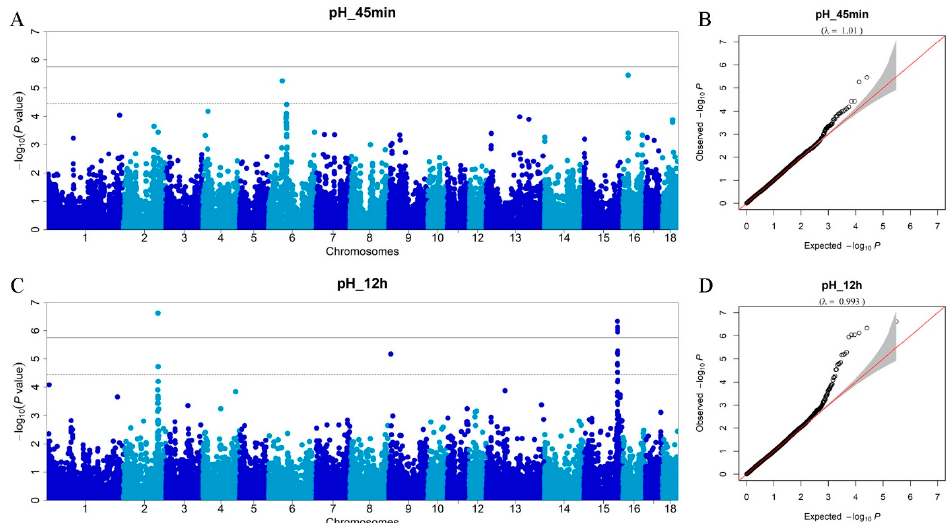
Figure 1. Linkage disequilibrium decay across the whole genome of the association panel. The red line represents the linkage disequilibrium threshold for the association panel ( r 2 = 0.2).